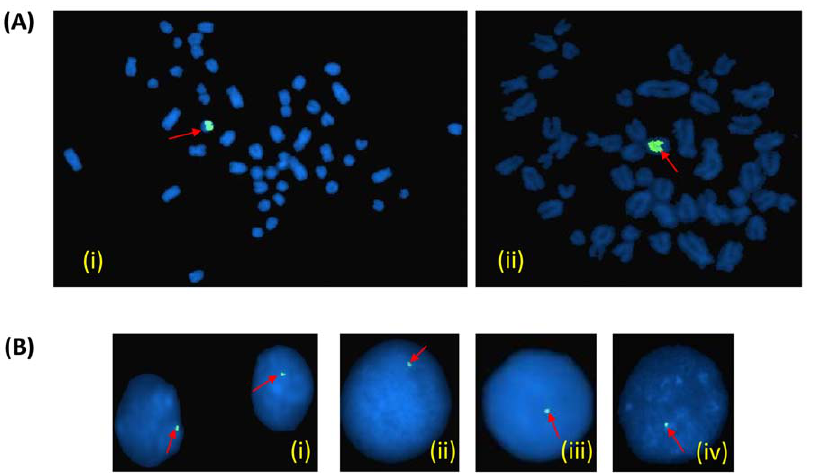
Figure 7. Chromosomal localization of TSPY1 - like gene. The TSPY1- like gene probe (arrows) localized to the water buffalo metaphase chromosome Y ( A ) (i and ii) and interphase nuclei ( B ) (i–iv).